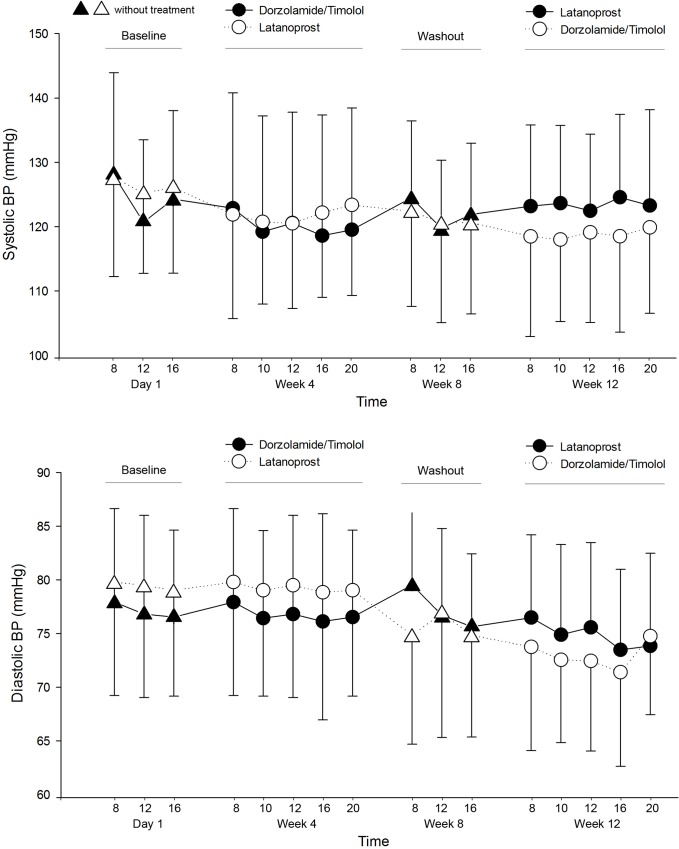
Mean systolic and diastolic blood pressure (BP) during the circadian curve for the three crossover phases: at baseline, after dorzolamide/timolol, and after latanoprost.Vertical bars indicate the 95% confidence interval of the estimates.